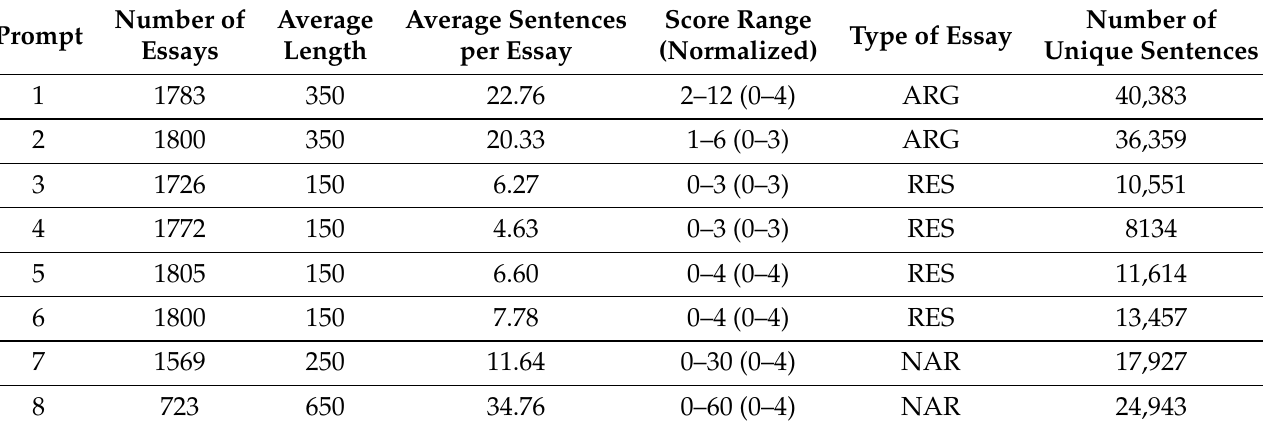
Table 2. Characteristics of the ASAP dataset. In the column “Type of essay”, ARG denotes argumen- tative essays, RES denotes source-dependent response essays, and NAR denotes narrative